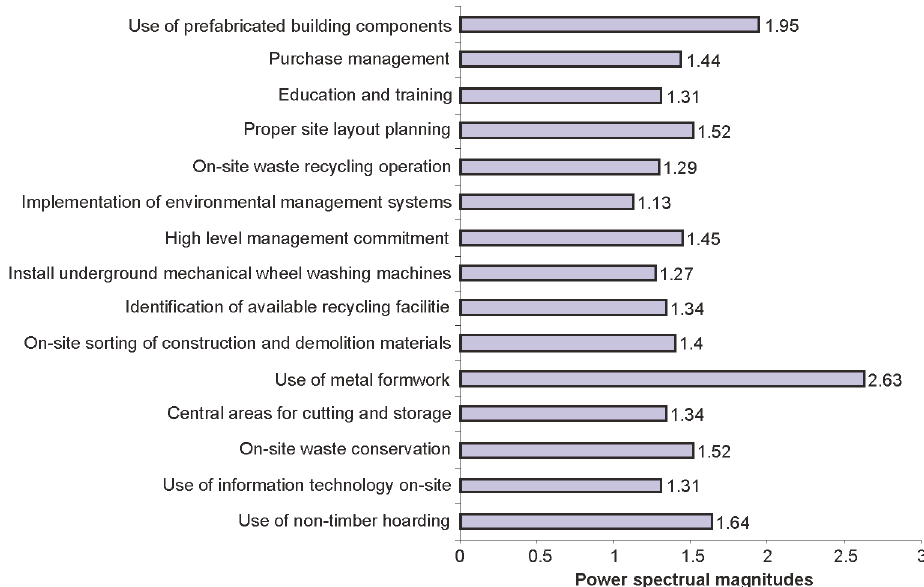
Fig. 9. Methods to encourage the implementation of waste management systems